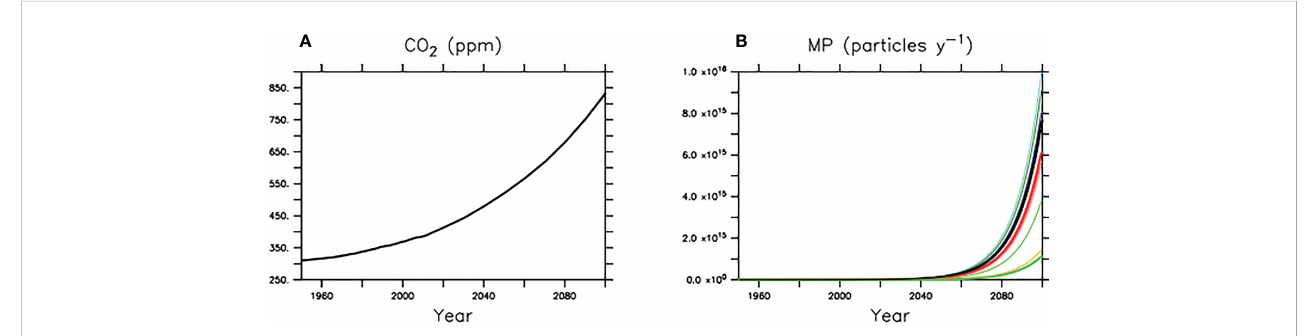
FIGURE 3 Earth system and microplastic model forcing. All models use equivalent CO 2 forcing (A) , but microplastic input rates are varied (B)